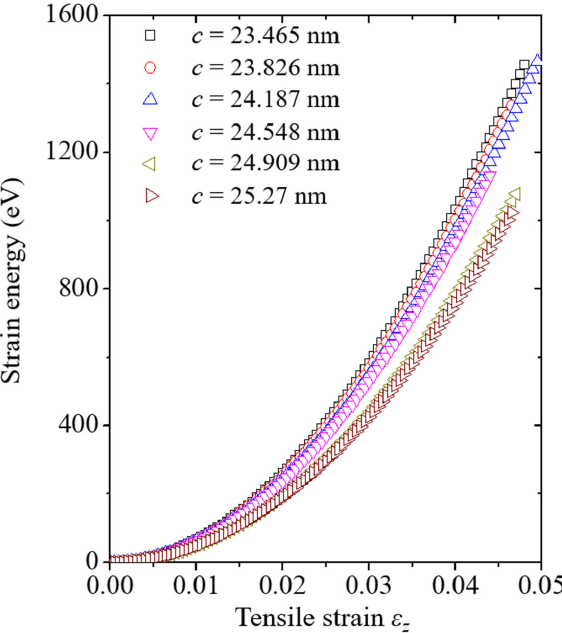
Figure 6. Strain energy of the (4,4) CNT model with various crack lengths corresponding to the tensile strain. c denotes the crack length in the model.